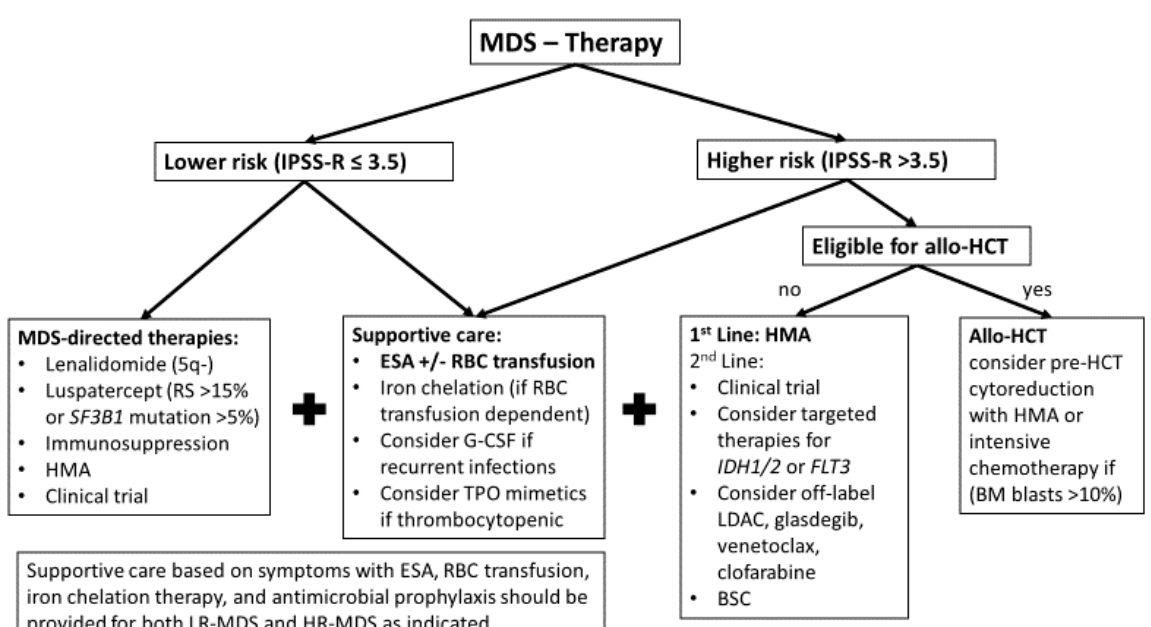
Figure 3. Potential treatment algorithm for MDS. Treatment selection for MDS patients depends on individualized risk assessment using validated scoring systems such as IPSS-R. All patients with MDS should receive supportive care based on their symptoms with erythropoiesis-stimulating agents (ESA), blood product transfusion (red blood cells [RBC] and platelets), iron chelation therapy, and antimicrobial prophylaxis if neutropenic [1,33]. TPO mimetics for thrombocytopenic patients and G-CSF in patients with recurrent infections can be considered as supportive care for MDS patients as well. However, the use of the latter two should be carefully considered due to concern for accelerated AML transformation with growth factor use. For patients with lower-risk MDS, especially if they are refractory to ESA and RBC-transfusion-dependent lenalidomide, luspatercept, immunosuppressive therapy, hypomethylating agents (HMA), or enrollment in clinical trials are potential options based on patient and disease characteristics [2,31]. Allogeneic hematopoietic cell transplant (allo-HCT) remains the only potentially curative therapeutic modality for MDS and all patients with higher-risk MDS (and selected lower-risk patients) should be considered for this curative modality [2]. If patients are allo-HCT eligible, pre-transplant cytoreduction with HMA or intensive chemotherapy can be considered if bone marrow blast percentage is >10%. For non-transplant patients, HMAs remain the standard of care [2,31]. In patients with HMA-failure, clinical trials, as well as the best supportive care (BSC) only are 2nd line modalities [2]. Data are limited on targeted therapies with IDH1/2 or FLT3 inhibitors. In the absence of the clinical trials option, the off-label use of low-dose cytarabine (LDAC), glasdegib, venetoclax, or clofarabine could be considered as a last line of